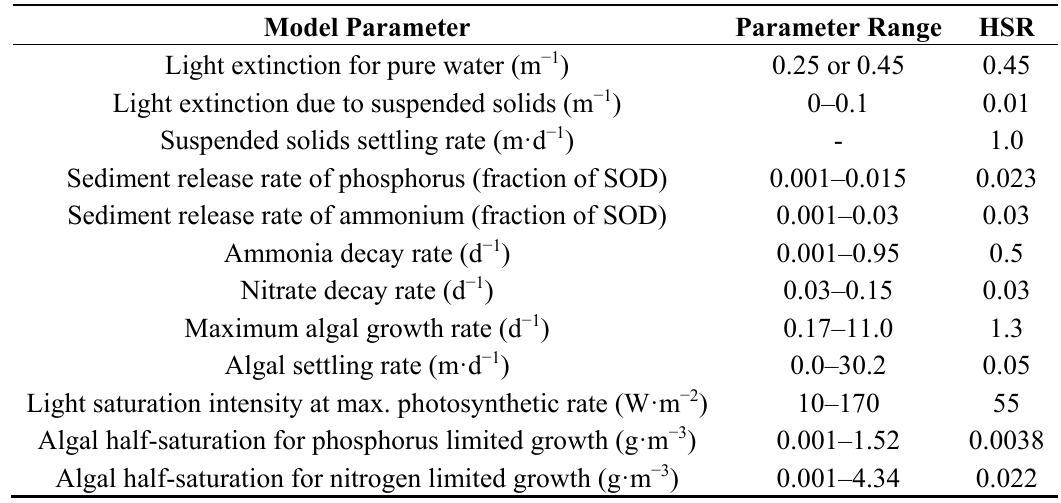
Table 2. The calibrated values of W2 water quality model kinetics parameters in